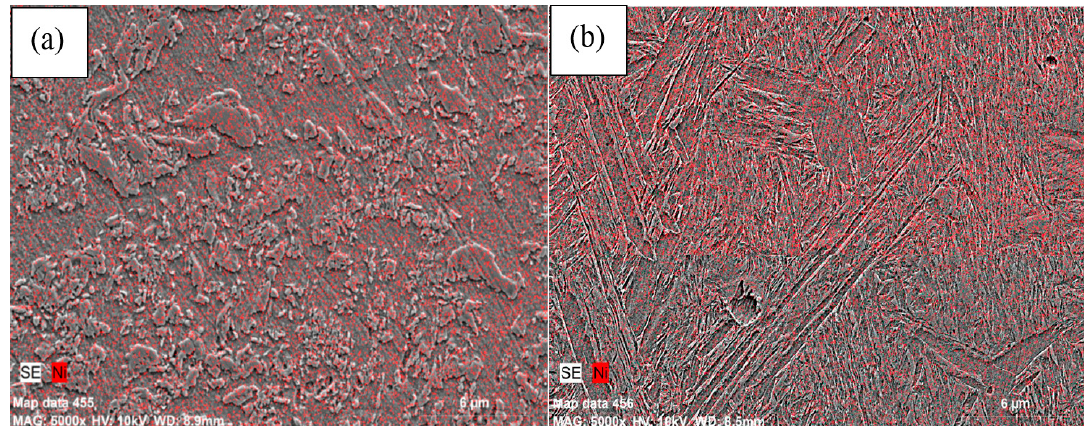
Figure 3. ( a ) SEM line EDS image of alloy 2 and ( b ) precipitates formed at grain boundaries.